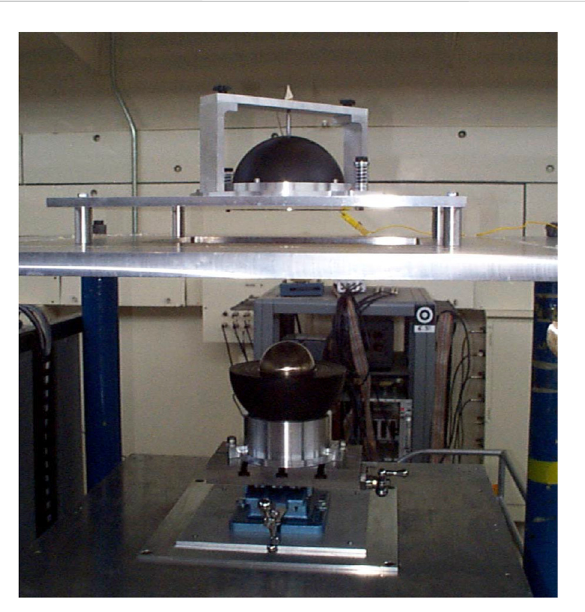
FIGURE 12 Np sphere with highly enriched uranium shells mounted in the planet